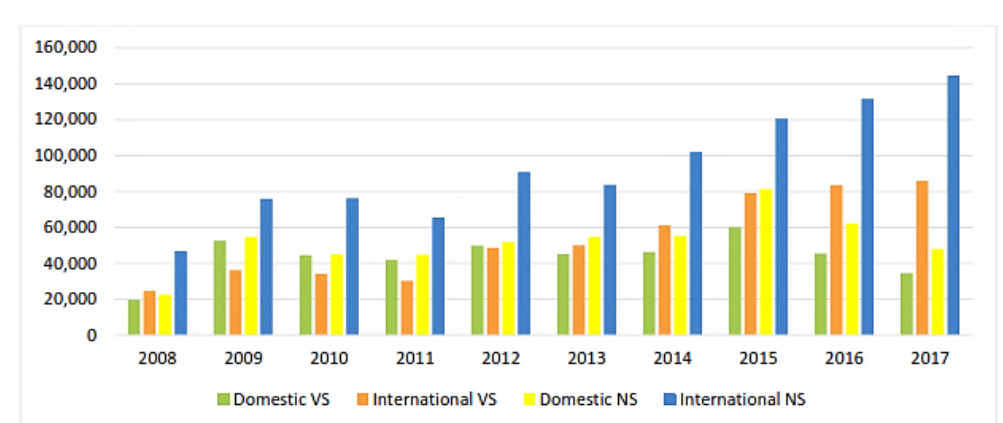
Fig. 3. Number of local and international visitors and nights spent (developed by the authors adapted from the KAS,